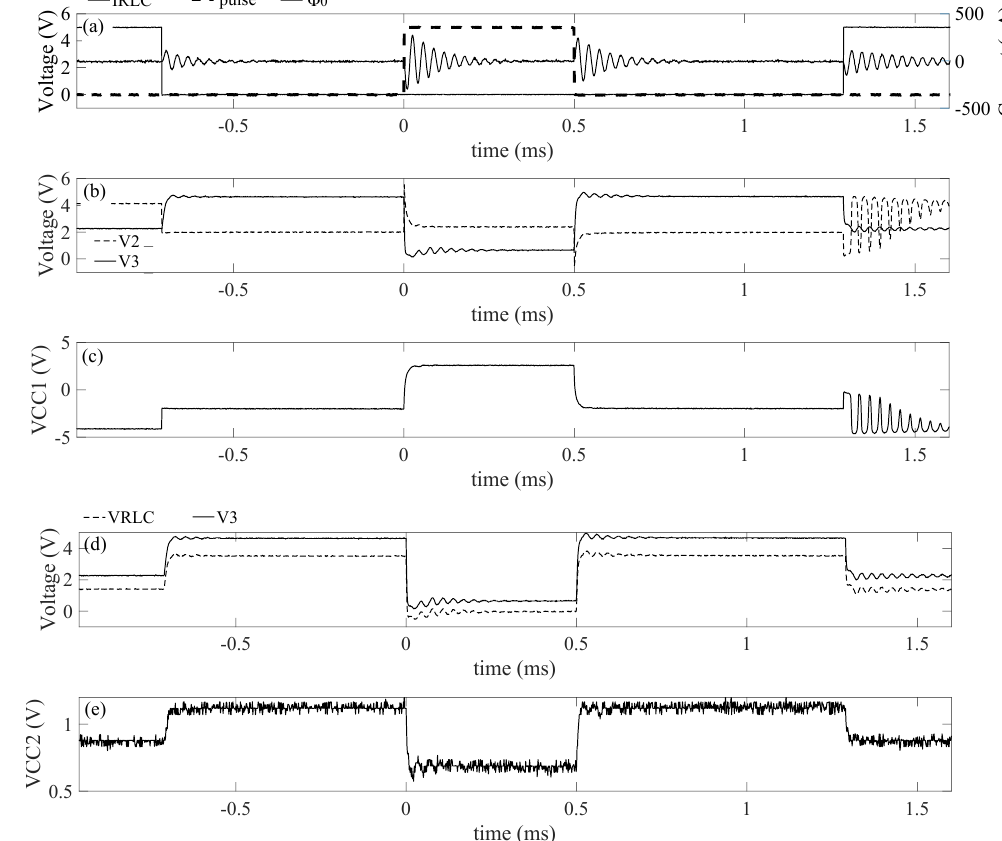
Figure 22. Measurement results in actuation mode for a Butterworth Van Dyke (BvD) load. ( a ) waveforms of the input pulse, the control signal Φ 0 and I RLC ; ( b ) input and output of the bidirectional amplifier; ( c ) drop voltage across the input coupling capacitor; ( d ) comparison between the output of the bidirectional amplifier V 3 and the voltage across the resonating load V RLC ; ( e ) drop voltage across the output coupling capacitor C C 2